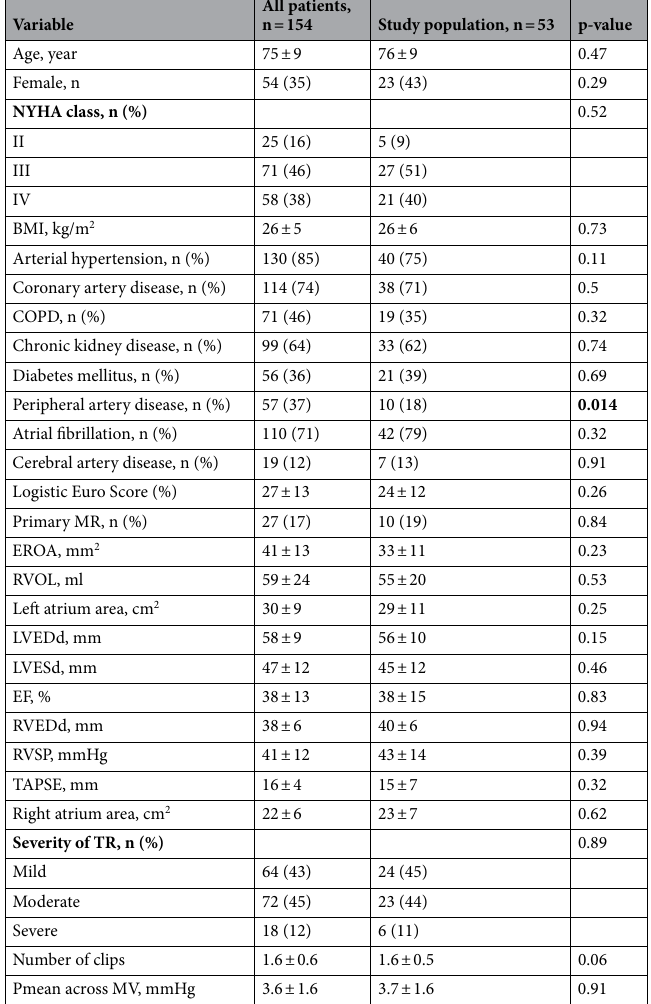
Table 2. Comparison of baseline characteristics between study population and all patients who received PMVR during study period. NYHA New York Heart failure Association, BMI Body Mass Index, COPD Chronic Obstructive Pulmonary Disease, MR mitral regurgitation, EROA Effective regurgitation orifice area, RVOL Regurgitant volume, LVEDd Left Ventricle END Diastolic diameter, LVESd Left Ventricle End Systolic diameter, EF Ejection Fraction, RVEDd Right Ventricle End Diastolic diameter, RVSP Right Ventricle Pressure measured in echocardiography, TAPSE Tricuspid annular plane systolic excursion, TR Tricuspid Regurgitation. Pmean: mean pressure across the mitral